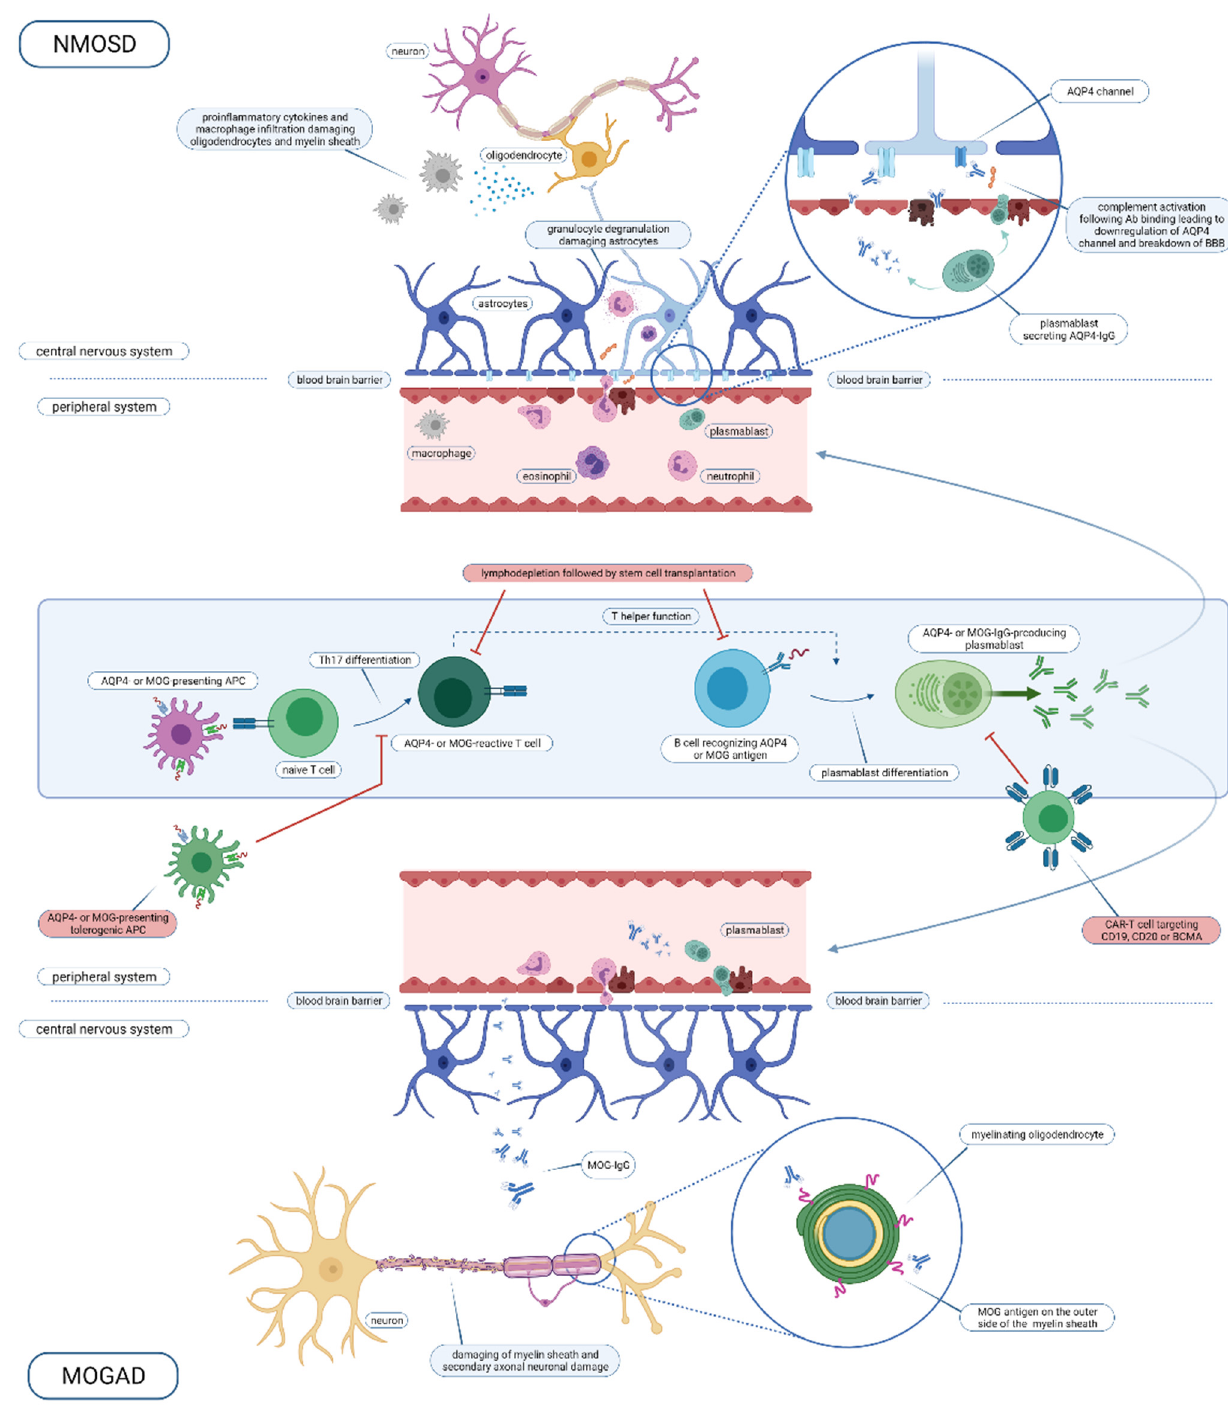
Figure 1. Overview of the NMOSD and MOGAD immune pathogenesis and intervention points for cell-based therapy. Abbreviations used: NMOSD, neuromyelitis optica spectrum disorder; AQP4, aquaporin-4; Ab, antibody; BBB, blood brain barrier; IgG, immunoglobuline G; MOG, myelin oligodendrocyte glycoprotein; APC, antigen-presenting cell; Th, T helper; CAR-T, chimeric antigen receptor T cell; CD, cluster of differentiation; BCMA, B cell maturation antigen; MOGAD, MOG-antibody disease. Created with BioRender.com.